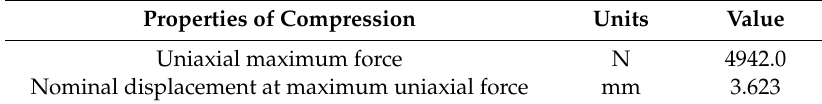
Table 10. Mechanical properties for the printed element achieved in the uniaxial compression test on the Z-axis.